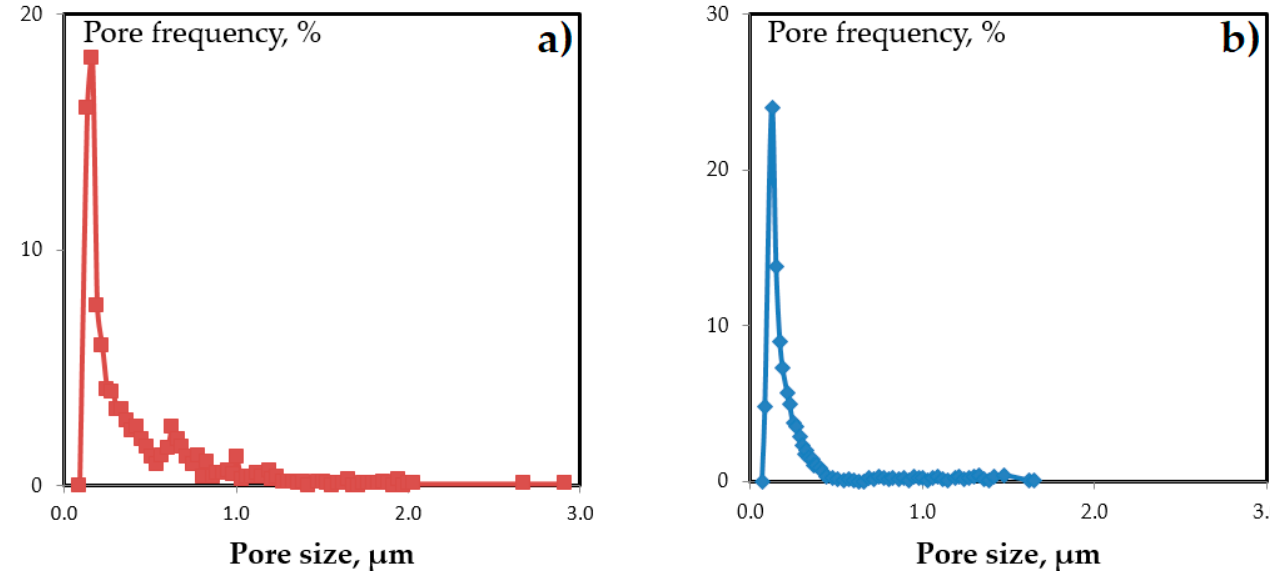
Figure 2. MFFK-1 ( a ) and UFFK ( b ) pore size distribution.